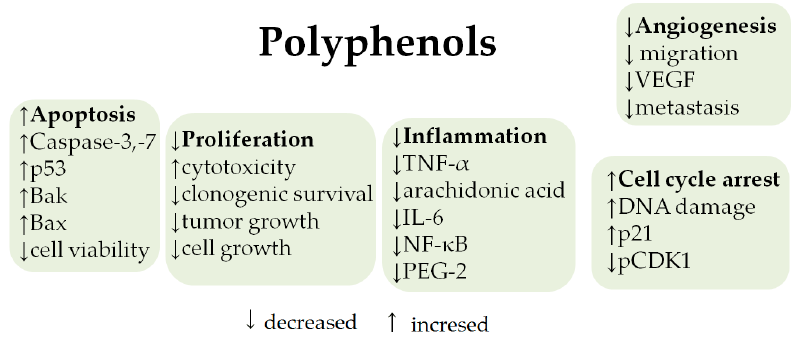
Figure 2. Anticancer mechanisms of polyphenols from olive oil [62].